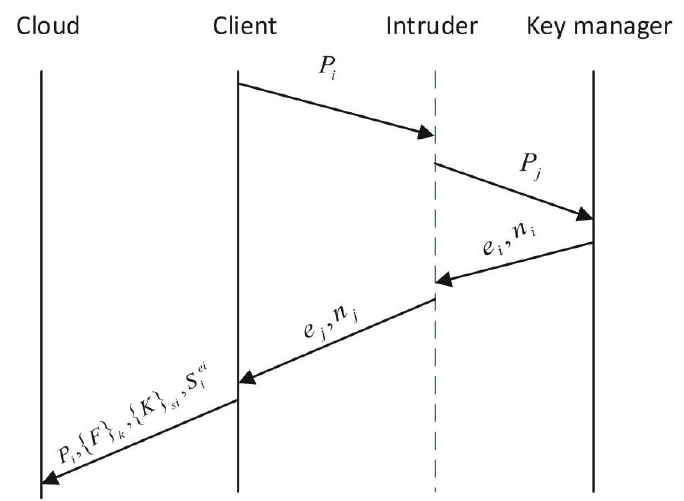
Figure 1. Man-in-the-middle attack during file upload.